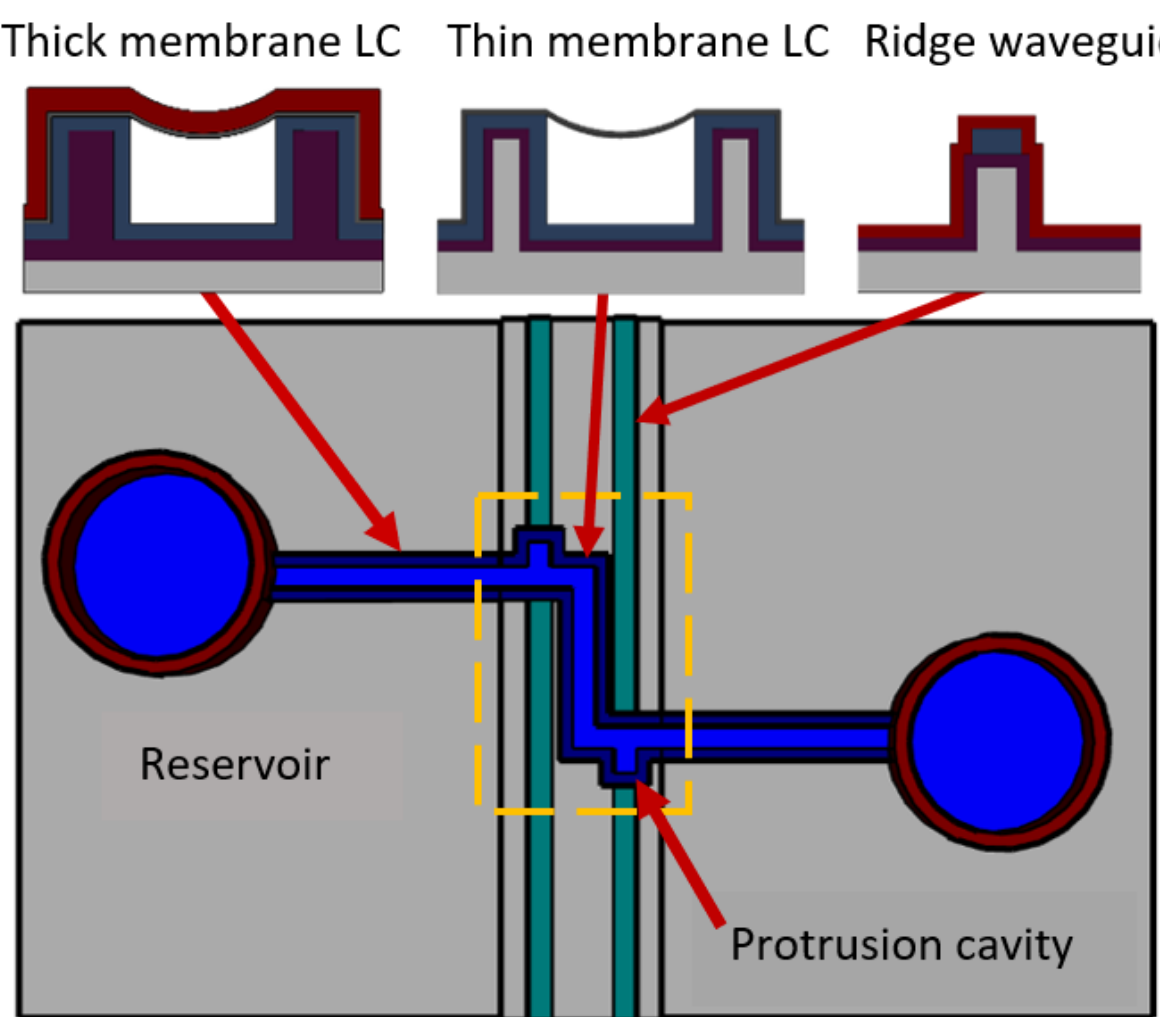
Figure 4. Optofluidic particle manipulation chip layout. Location of the thick membrane LC, thin membrane LC, and ridge waveguide all defined.